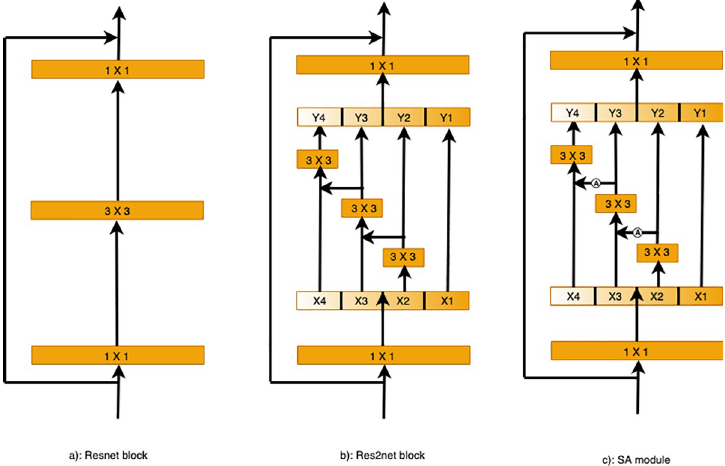
Fig 3. Comparing the Res2Net and ResNet blocks (with a scale dimension of k = 4): (a) The conventional building block in CNN variants. (b) Res2Net uses a group of 3 × 3 filters. (c) The SA module adds the attention module to enforce the scale-attention